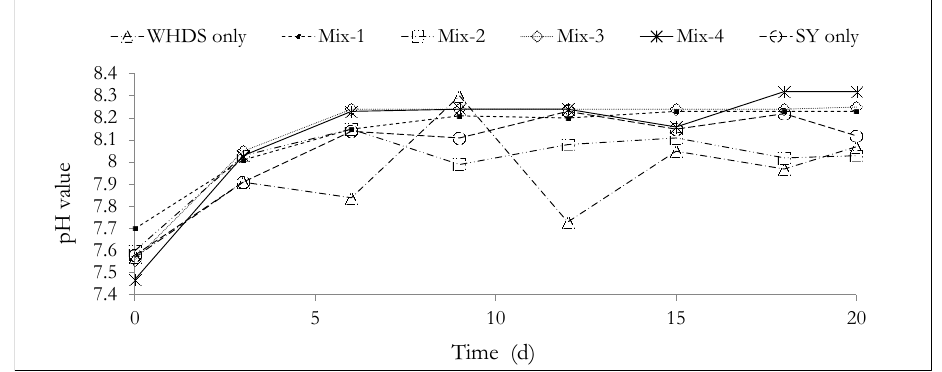
Figure 5. Analyzing the pH changes during the anaerobic degradation process. The mass ratios of the volatile solids of WHDS to the volatile solids of SY for the different substrate mixtures are listed in Table 3.